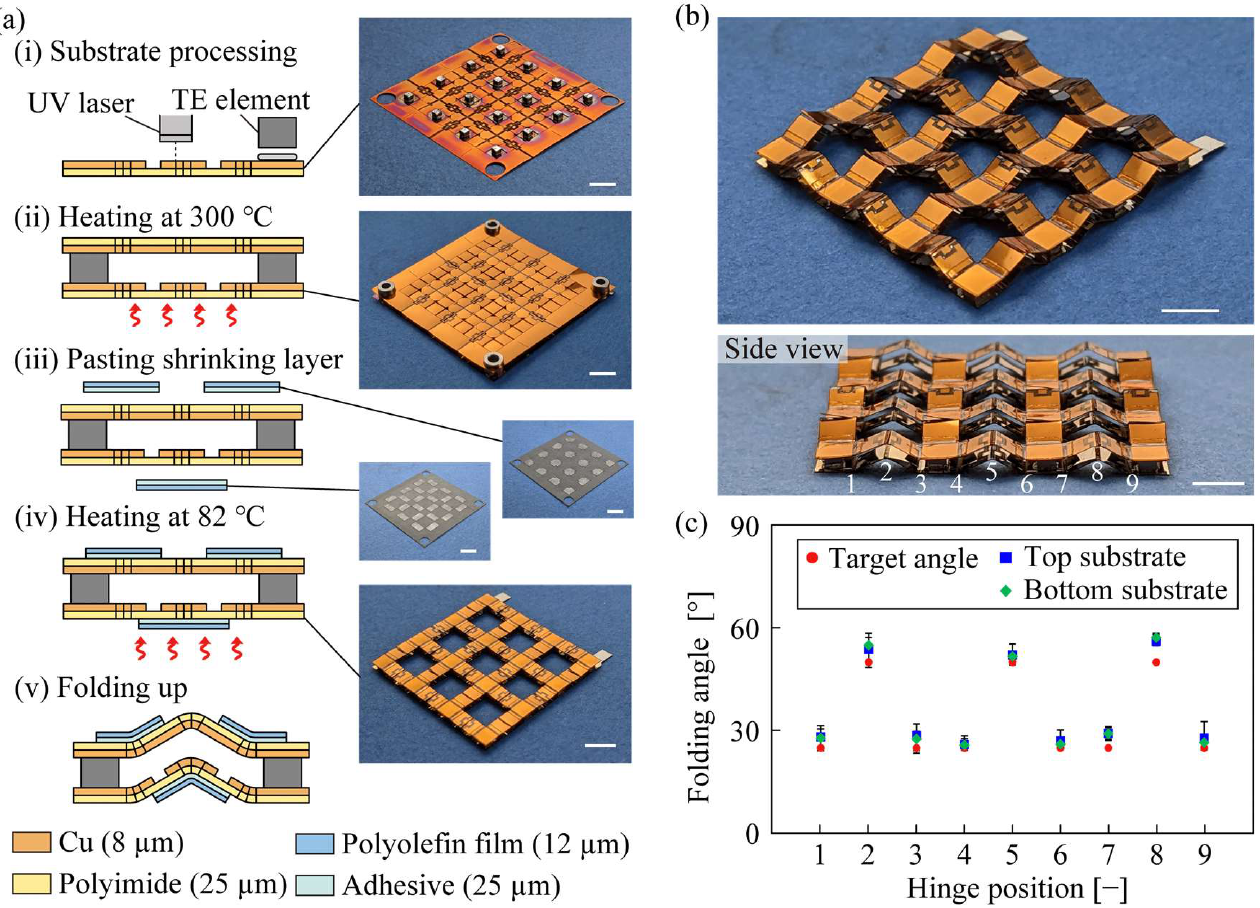
Figure 3. Fabrication process. ( a ) Detailed fabrication procedure of origami-TEG. ( b ) Photograph of origami-TEG after self-folding. ( c ) Accuracy of the self-folding angle of each hinge. The scale bar was 5 mm.